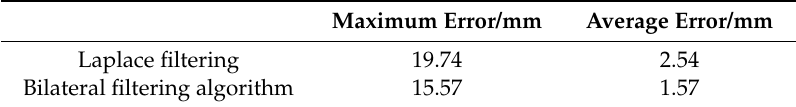
Figure 11. Algorithm comparison for the denoising effect. ( a ) Raw data; ( b ) denoising effect of the Laplace algorithm; ( c ) denoising effect of the bilateral filtering algorithm. Table 2. Comparison of algorithm performance.